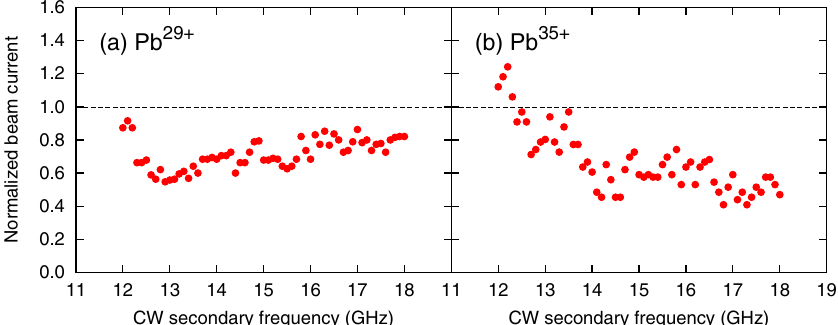
FIG. 6. Pb 29 þ and Pb 35 þ afterglow beam currents as a function of the secondary frequency operated in CW mode normalized to the single frequency beam currents ( 190 μ A for Pb 29 þ and 33 μ A for Pb 35 þ ). The main frequency of 14.5 GHz is pulsed with 1920 W and the secondary frequency is operated at a constant 200 W